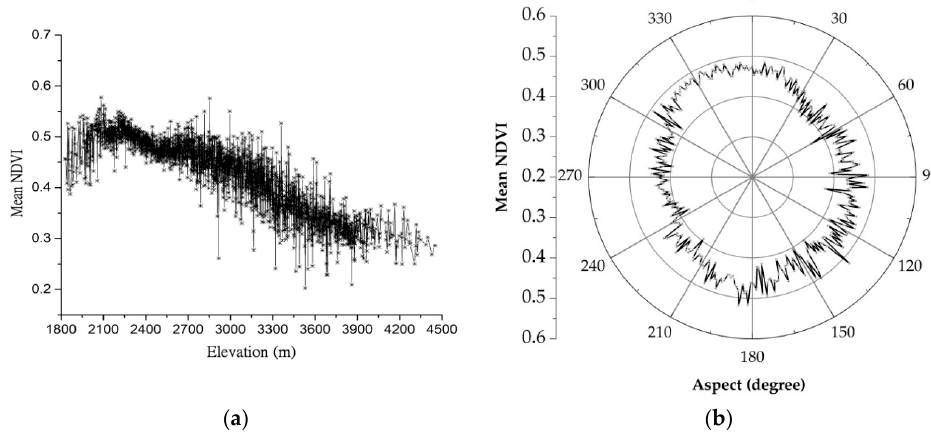
Figure 4. Scatter plot (spline connected) showing the Variation of NDVI ( a ) per elevation (Vertical) and ( b ) a Rose chart showing the variation of NDVI per aspect (horizontal) in the Virunga-Volcanoes massif.